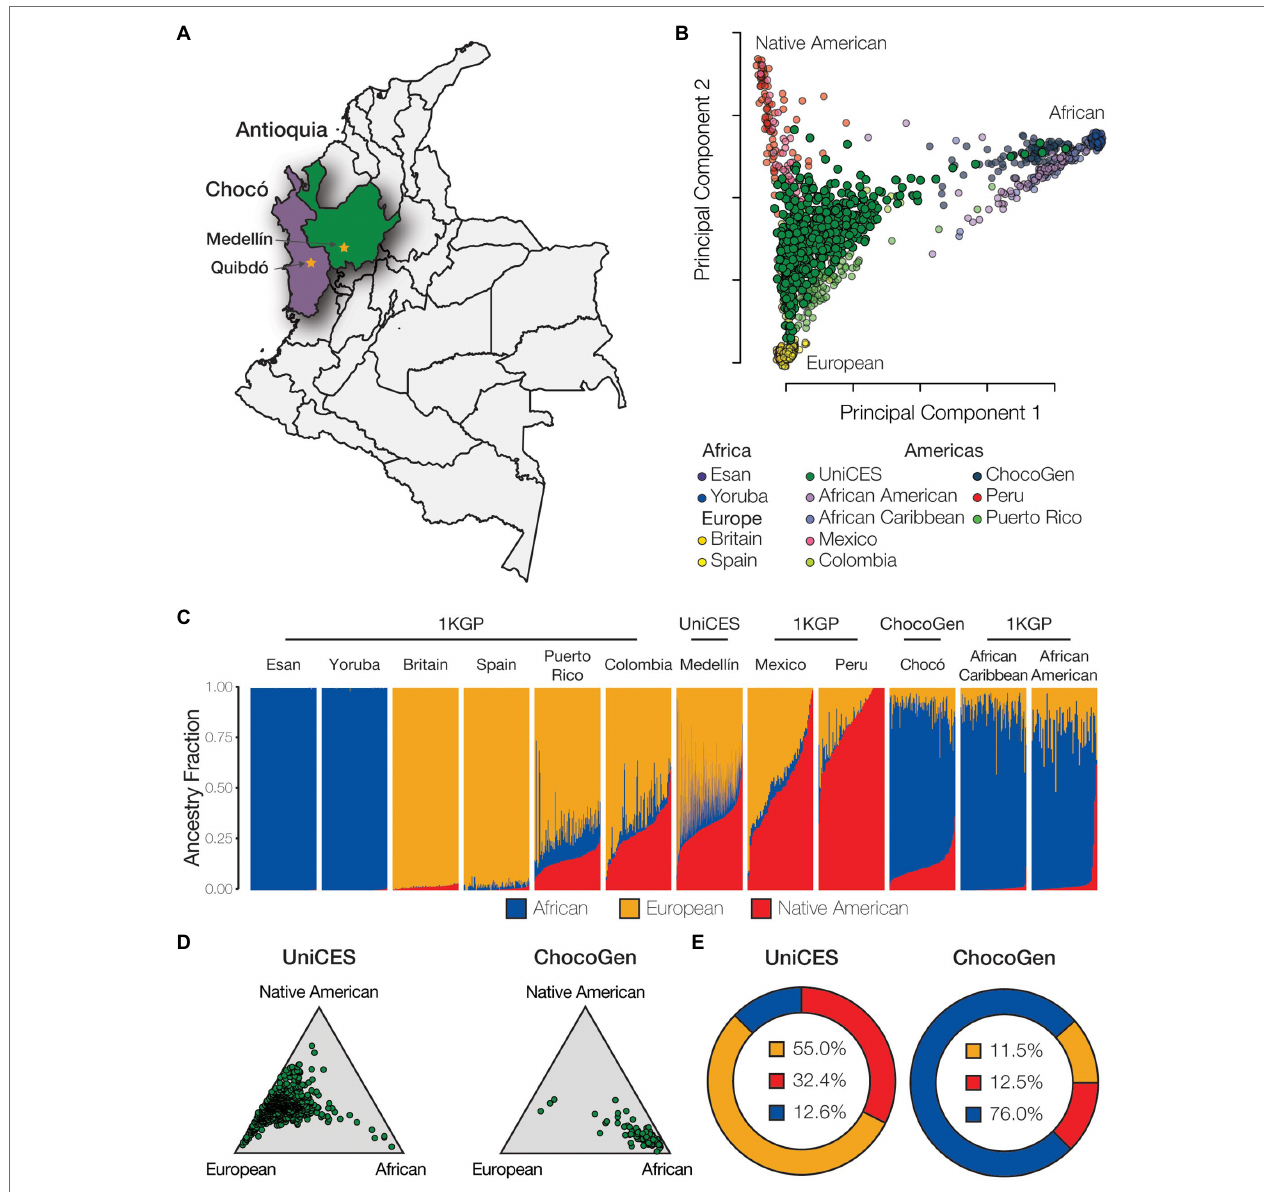
FIGURE 2 | Genetic ancestry and admixture. (A) Cohort sampling locations in Medellín, Antioquia and Quibdó, Chocó. (B) Principal component analysis (PCA) showing the genetic relationships among individuals from admixed American populations, including the Colombian populations studied here, together with European, African, and Native American reference populations. (C) ADMIXTURE plot showing the patterns of genetic ancestry fractions – European (orange), African (blue), Native American (red) – for individuals from admixed American and global reference populations. (D) Ternary plots showing the relative distributions of continental ancestry for the Medellín and Chocó cohorts studied here. (E) Population average ancestry fractions for the for the Medellín and Chocó cohorts. Population abbreviations: 1KGP – 1,000 Genomes Project, ChocoGen – Chocoano in Quibdó, Colombia, UniCES – Cosmopolitan Colombian in Medellín,